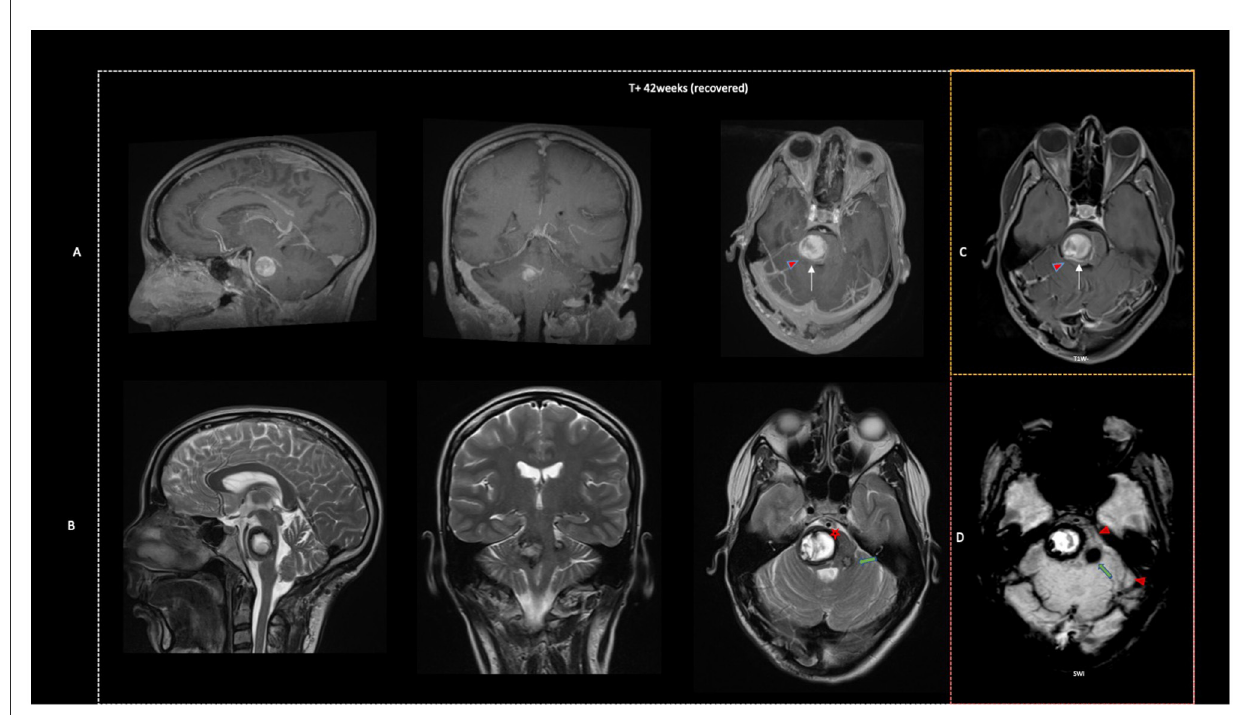
FIGURE5 Improvement at 6 months. Sagittal, coronal, and axial MRI: (A) T1W + Gad; (B) T2W axial only: (C) T1W; and (D) SWI. Signal characteristics consistent with late-stage subacute hematoma or extracellular meth-Hb are seen as persisting T1W and T2W hyperintense signals (black star) in the surgical cavity. The additional appearance of a thick hemosiderin ring with hypointense T1, hypointense T2 signal (red star), and clear evidence of thrombus (T1W hyperintensity with reduced filling on T1W + gad) within the DVA system on the right (red arrowhead). The target CCM is confirmed as no longer present on T2* and SWI. The contralateral CCM (green arrow)